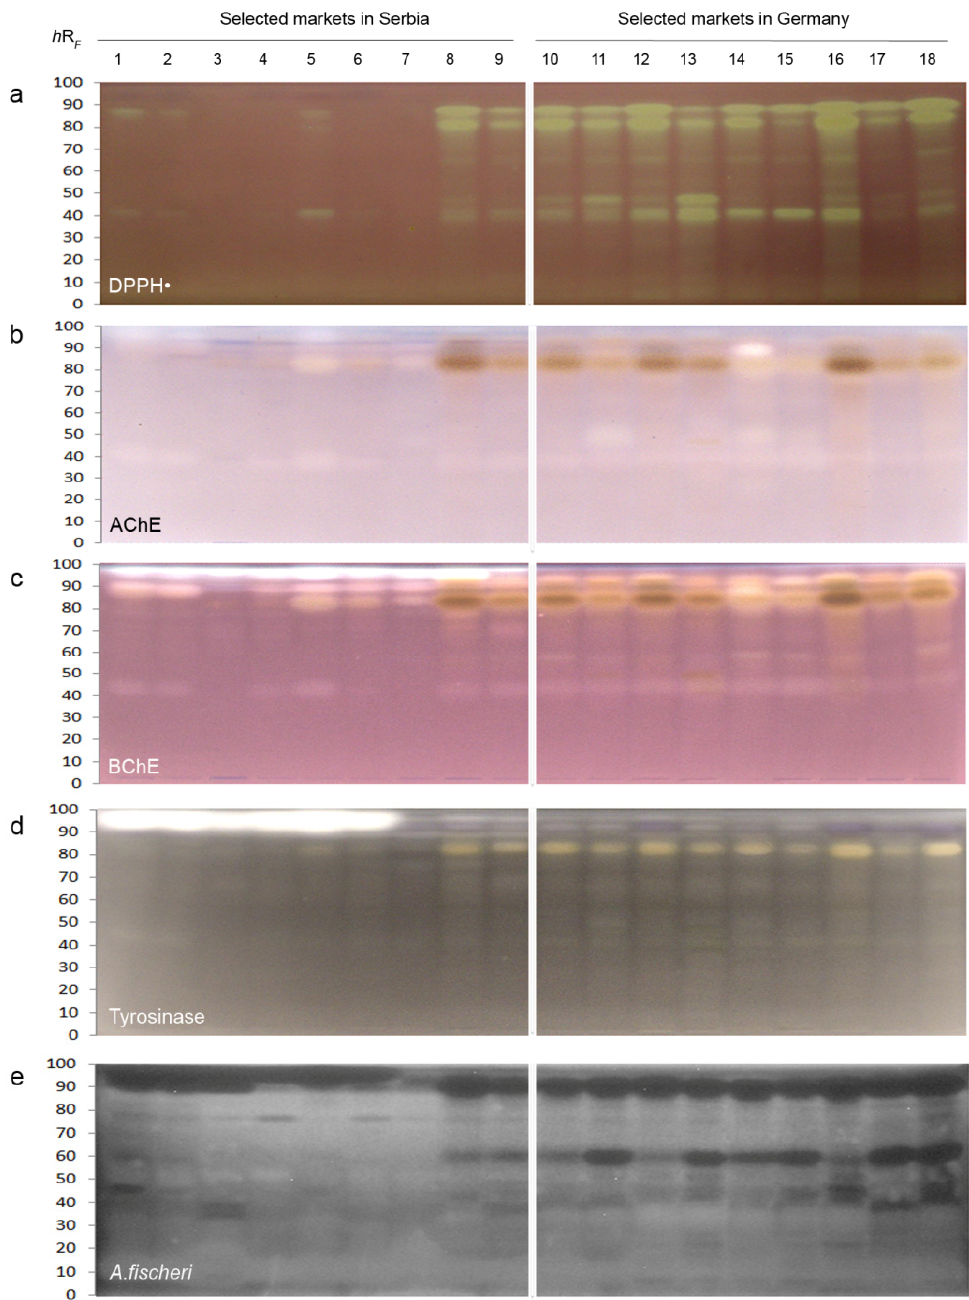
Figure 3. HPTLC profiles of extracts of grape juices from selected markets in Serbia and Germany after the ( a ) DPPH • assay, ( b ) acetylcholinesterase (AChE), ( c ) butyrylcholinesterase (BChE), and ( d ) tyrosinase inhibition assays, all detected under white light illumination, and ( e ) after the Aliivibrio fischeri bioassay with the recorded bioluminescence depicted as greyscale image.